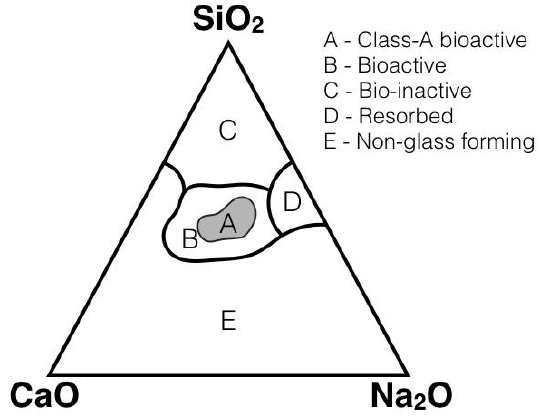
Figure 1. Property changes of bioglass materials (adapted from Tilocca [5]).